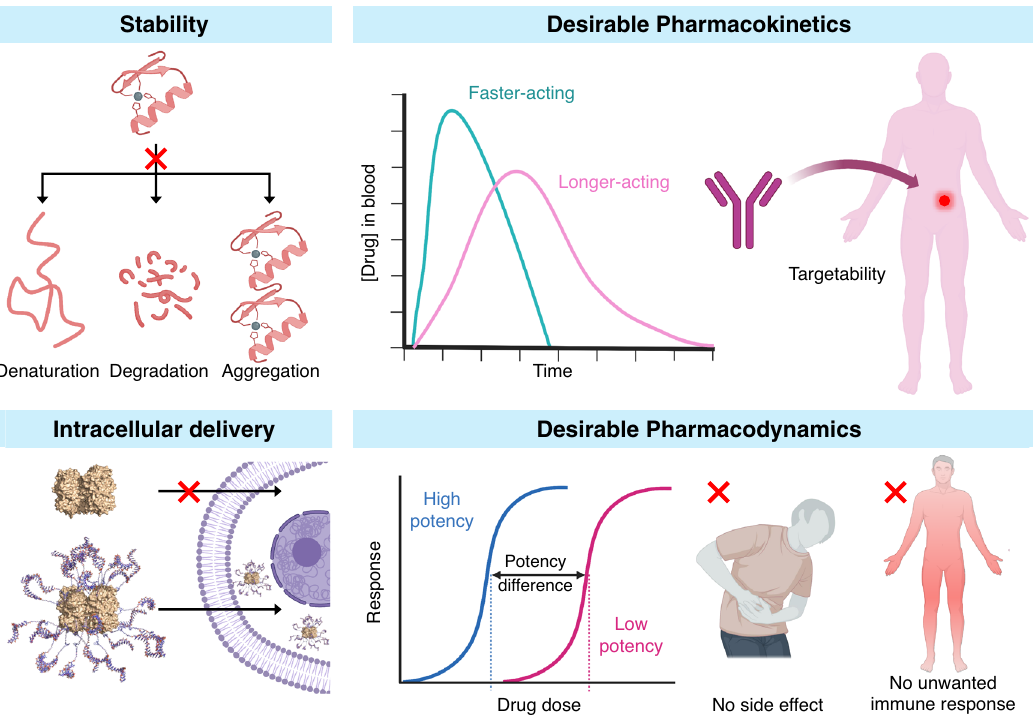
Fig. 2 | Desirable characteristics of protein-based therapeutics. These include high stability (top left), ability to enter cells (bottom left), and appropriate pharmaco- kinetics (top right) and pharmacodynamics (bottom